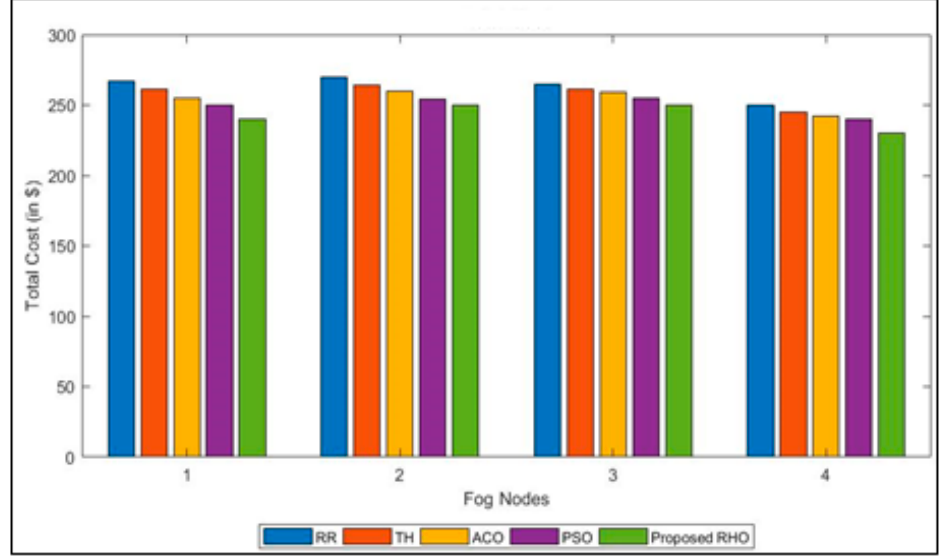
Figure 7. Total Cost for different algorithms for different Fog Nodes .